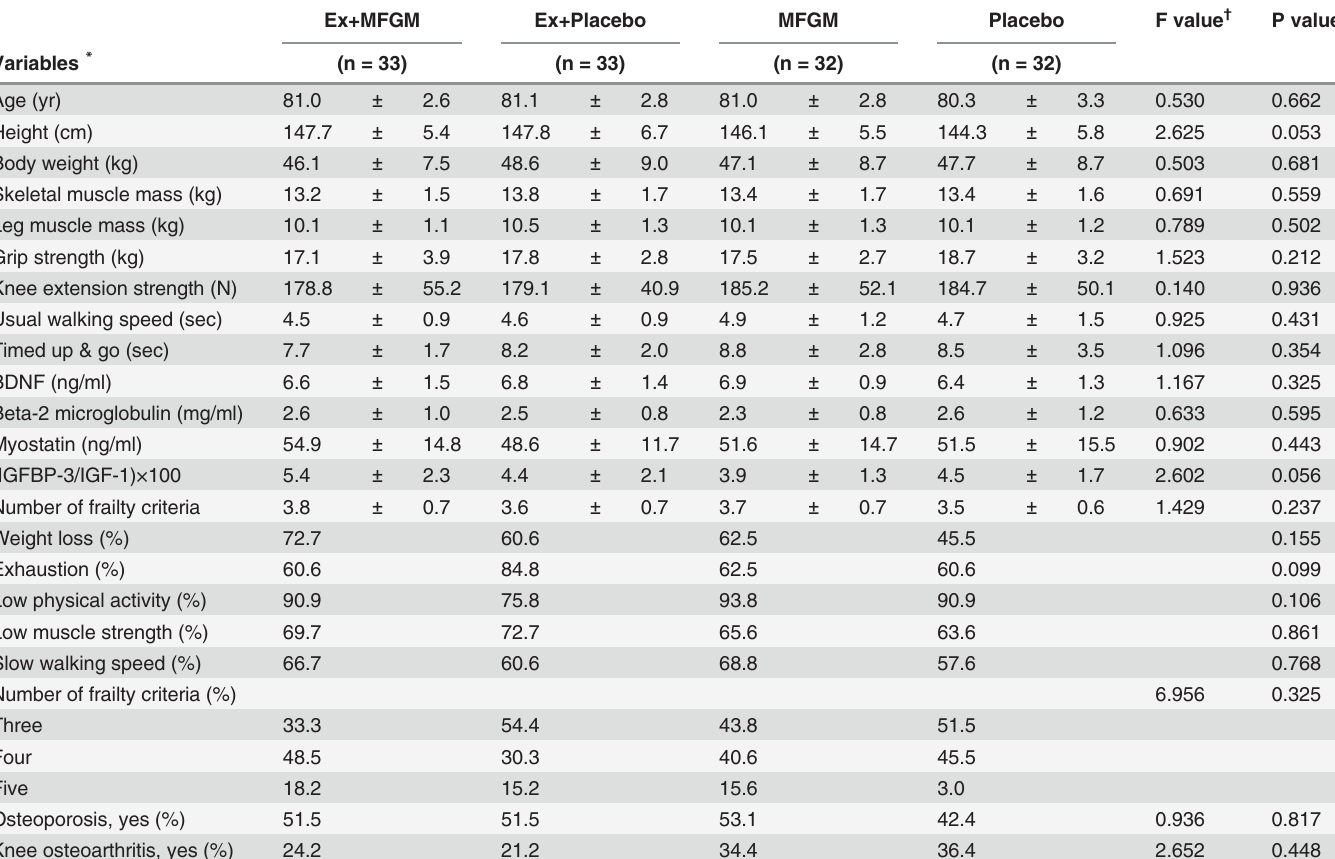
Table 1. Selected variable characteristics of participants at baseline by study